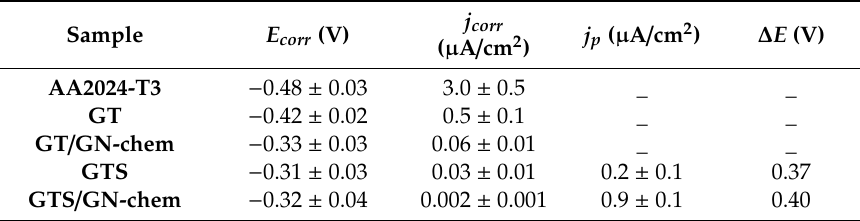
Table 3. Electrochemical parameters: corrosion potential ( E corr ), corrosion current density ( j corr ), passivation current ( j p ) and passive region ( ∆ E ) of bare AA2024-T3 and substrates coated with sol–gel coatings with and without graphene nanosheets. The parameters determined from potentiodynamic polarization curves (Figures 4 and